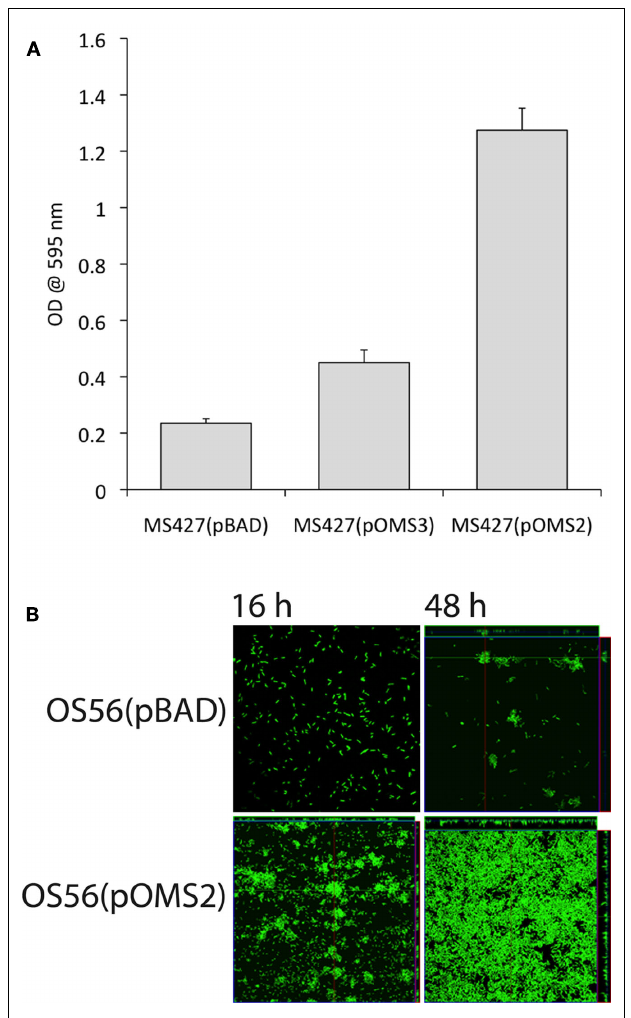
FIGURE 3 | (A) Glycosylated EhaJ [MS427(pOMS2)] mediates enhanced static biofilm formation in a microtiter plate assay at both 28˚C and 37˚C. Results are expressed as the average of six technical replicates within each plate; error bars indicate SD.These results are representative, confirmed by three independent experiments. (B) Glycosylated EhaJ mediates enhanced biofilm formation in a dynamic flow cell system at 28˚C. Spatial distribution of dynamic biofilm formation by GFP-labeled E. coli strains OS56(pBAD-kan) and E. coli OS56(pOMS2-kan) was monitored by confocal scanning laser microscopy at 15h (left) and 48h (right) after inoculation. Shown are representative horizontal sections collected within each biofilm and vertical sections (to the right and below for each individual panel) representing the yz-plane and the xz-plane, respectively, at the positions indicated by the white